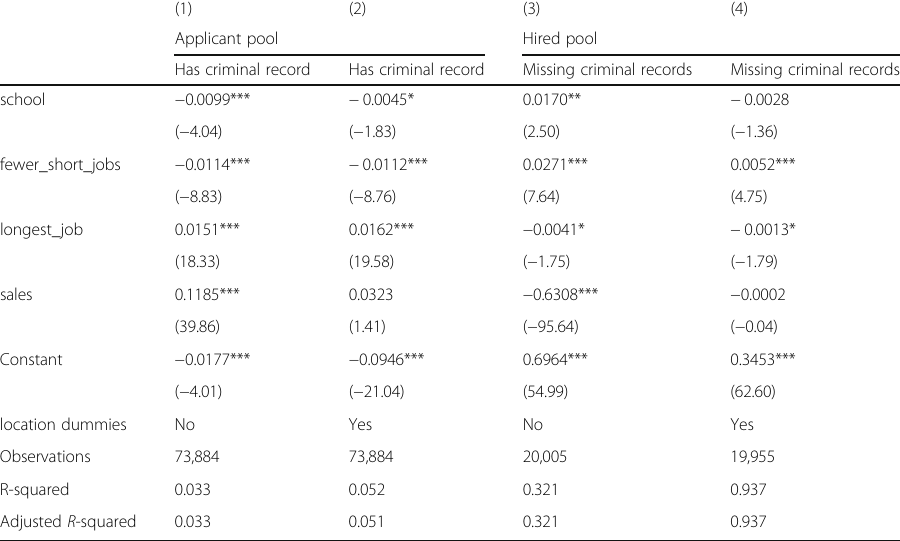
records in hired pool (customer service and